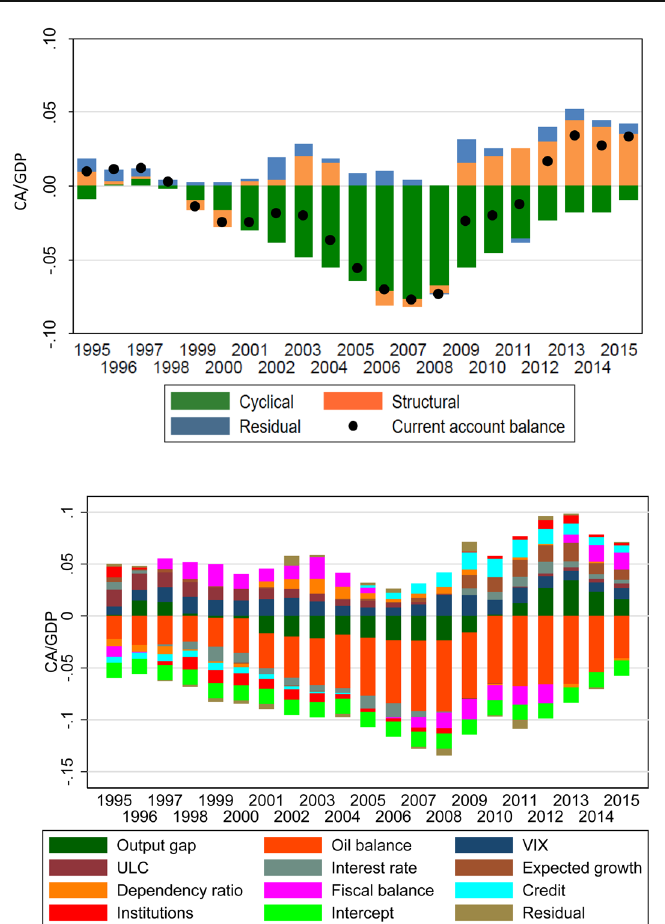
Fig.3 Current account decomposition. Notes. The upper panel plots the cyclical and structural components of the Spanish current account together with the residual term identified from Eq. (2). The bottom panel plots the detailed decomposition with the contribution of each of the regressors included in the analysis (oil balance also includes oil